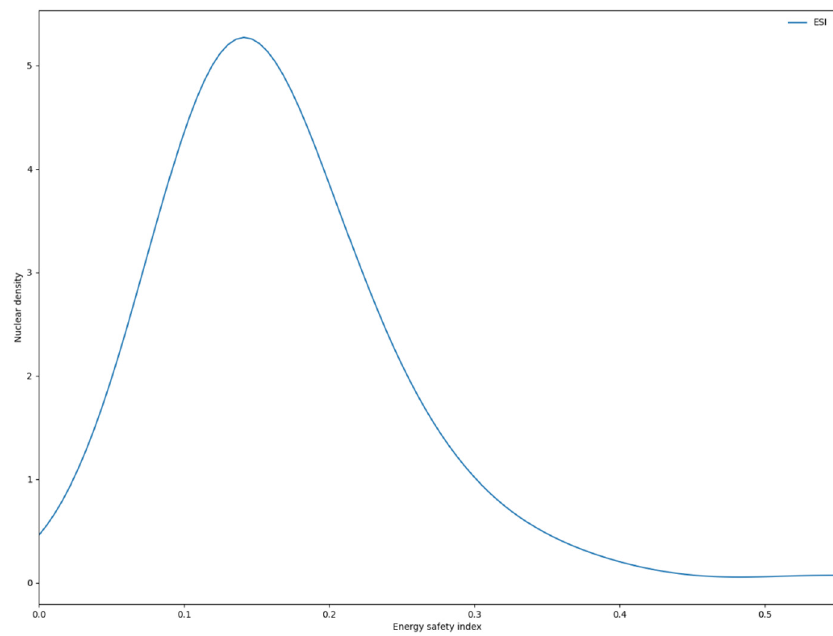
Figure 13. Kernel density estimates for the global energy security total index.